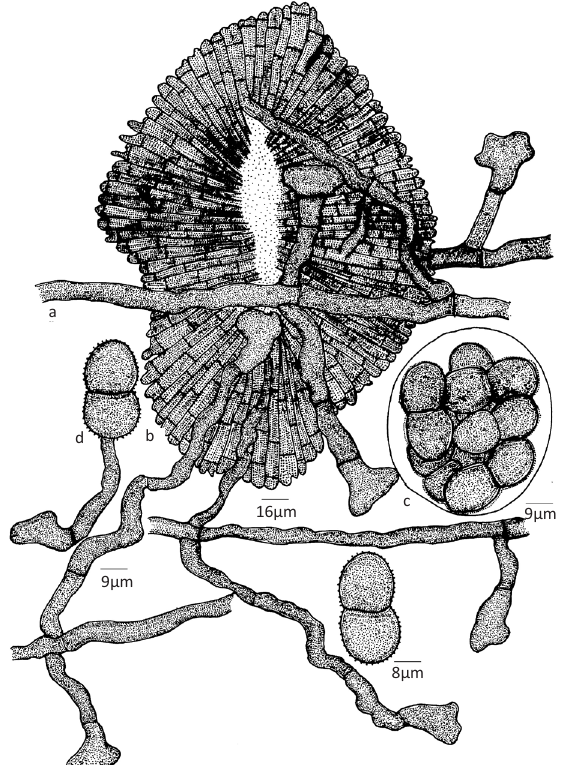
Figure 3. Lembosia hopiigena sp. nov. a - Appressoriate mycelium; b - Thyriothecium; c - Ascus; d -